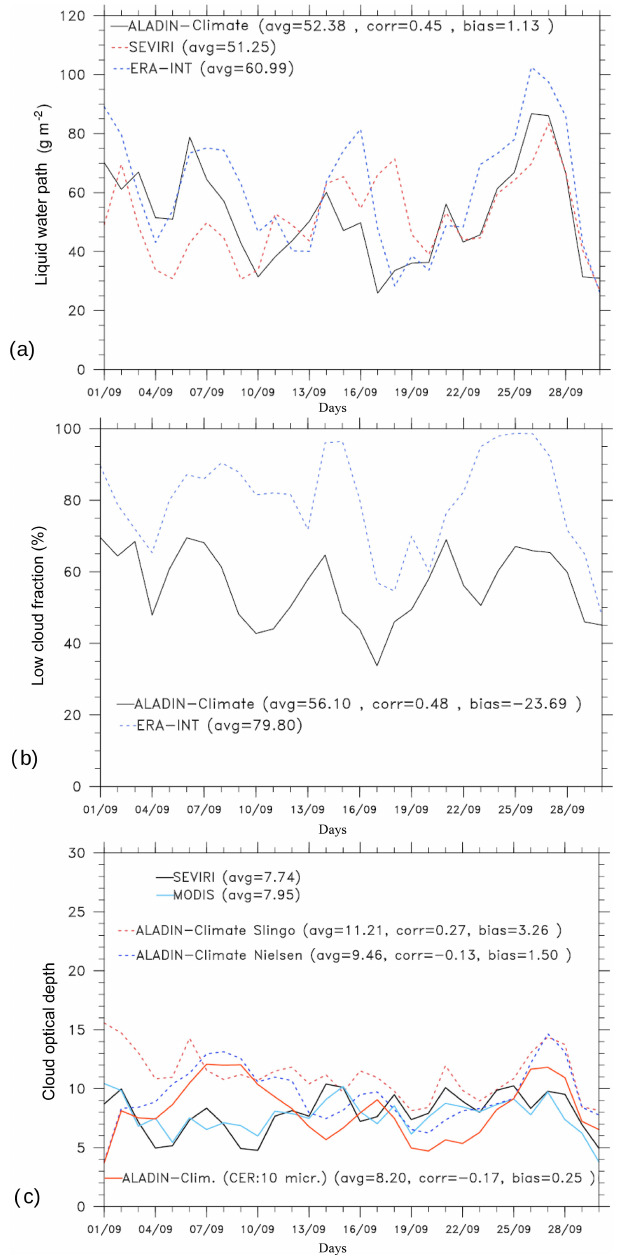
Figure 2. Daily mean Sc properties (LWP, LCF and COD) simu- lated by ALADIN-Climate and from ERA-INT and SEVIRI data. Values have been averaged over